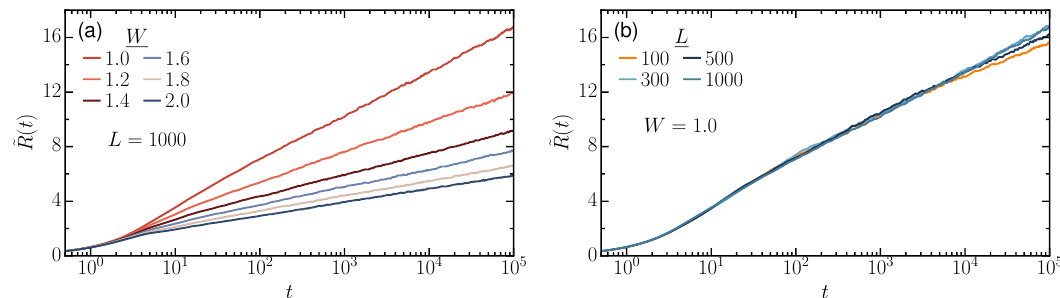
Figure 3: RMS displacement ˜ R ( t ) as a function of time showing logarithmic transport in the system. (a) For various disorder strengths W and L = 1000, and (b) for various system sizes L and W =